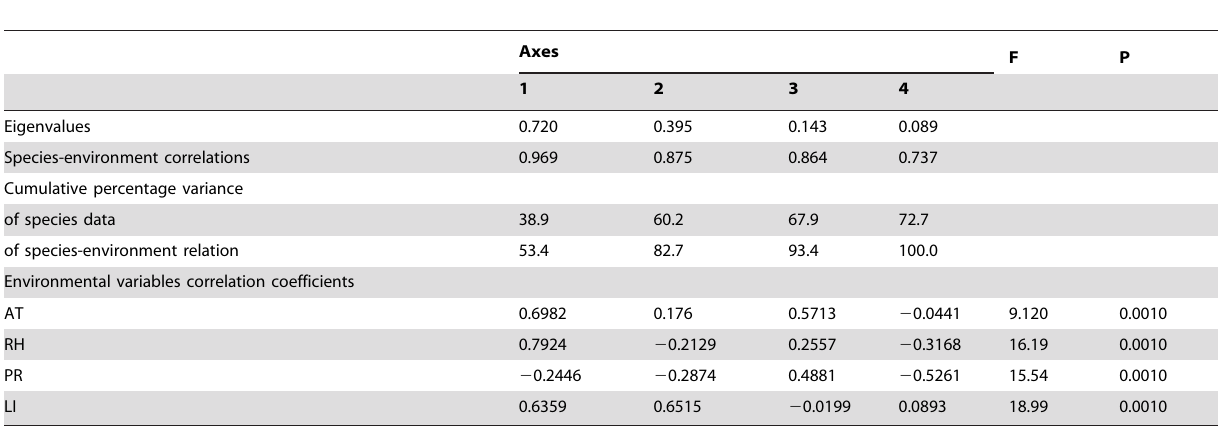
Table 4. Results of the CCA, showing eigenvalues, cumulative explained variance of species data, species–environment correlation coefficients, and correlation coefficients of the environmental variables for the 4 axes